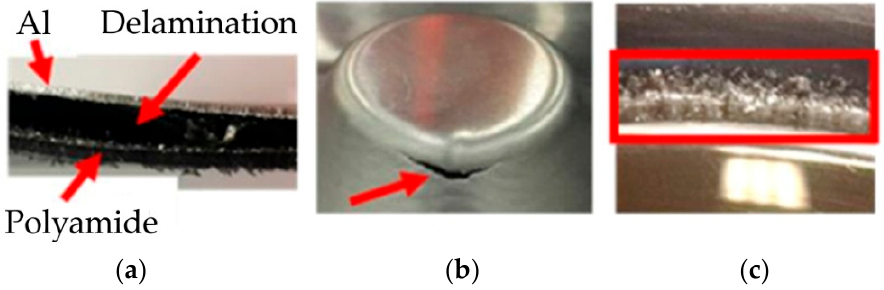
Figure 20. Types of failure: ( a ) delamination, ( b ) metal tearing, and ( c ) galling (reproduced with permission from [277]; copyright© 2021 The Author(s). Published by Elsevier B.V.).